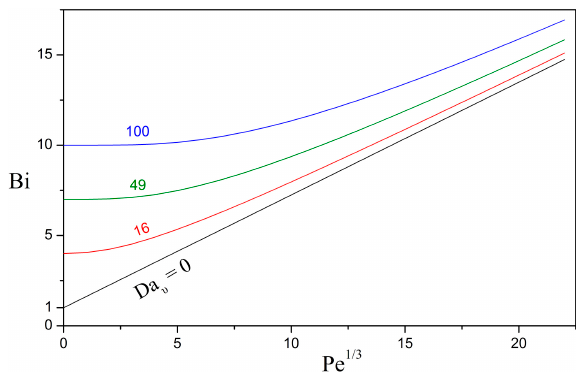
Figure 2. Impact of the Péclet and Damköhler numbers on the Biot number, for Λ (cid:3002)(cid:3081) = 1 , (cid:1834) (cid:3002),(cid:3100)/(cid:3081) = 1 .